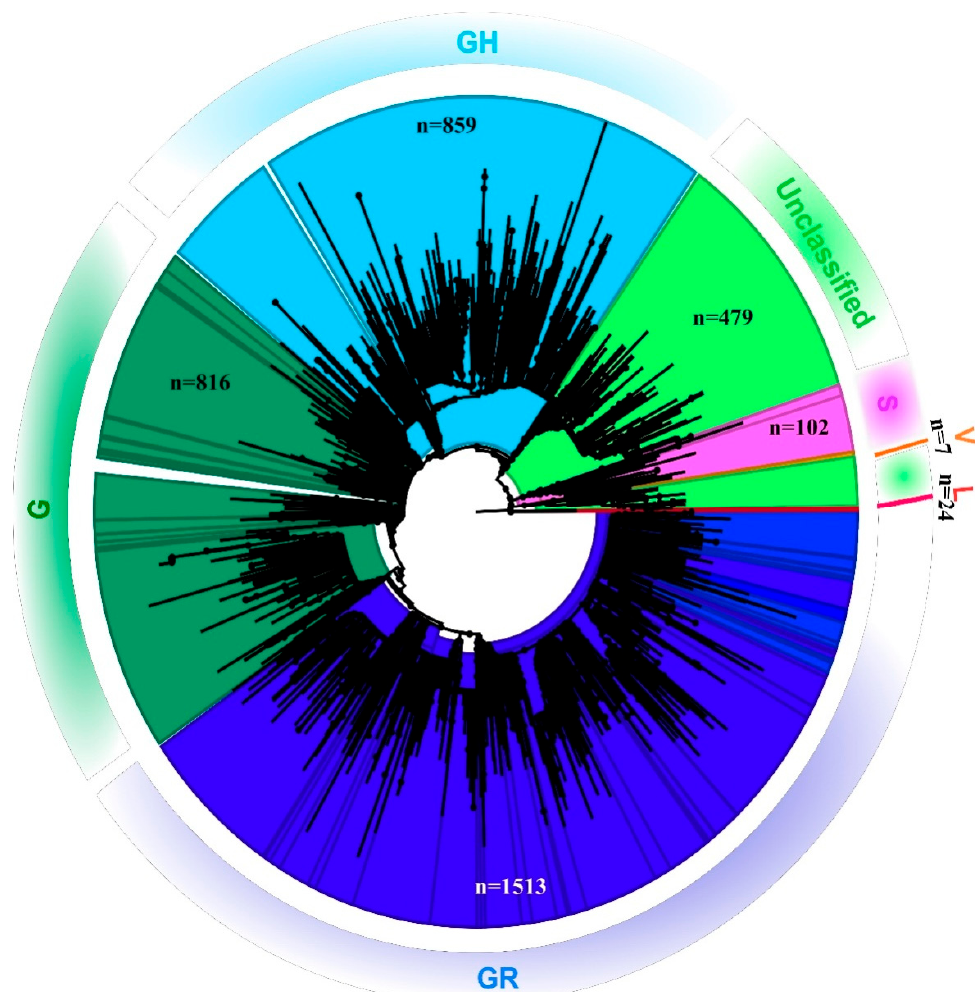
Figure 1. Phylogenetic tree of the SARS-CoV-2 genome: Neighbor-joining tree for Indian SARS- CoV-2 sequences with a bootstrap replication of 1000 cycles. FigTree v1.4.4 was used to visualize the generated tree. Various GISIAD clades of the SARS-CoV-2 are marked in different colors. The number of sequences used to generate the tree is assigned the n value.